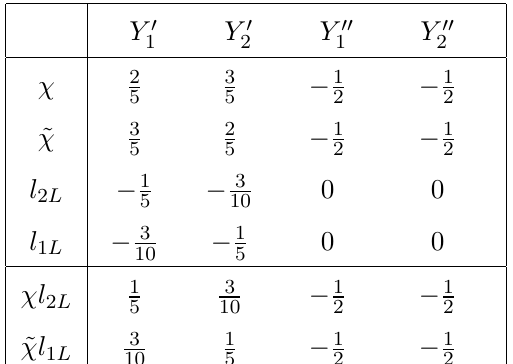
Table 1 . Charge assignment under U(1) 0 factors are the abelian subgroups inside SU(5) while the double primed abelian groups live outside. The gauged U(1) 1 (cid:2) U(1) 2 correspond to the sums Y b = Y 0 Y = Y 1 + Y 2 gives the